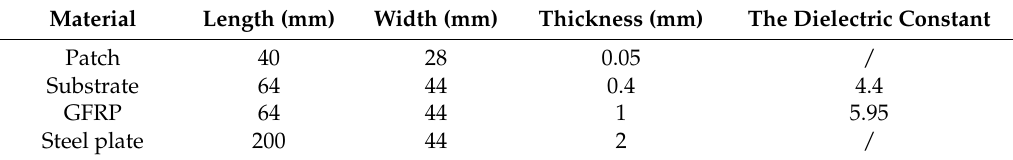
Figure 2. Multi-sectional view of the dual-substrate antenna sensor. Table 1. Geometrical dimensions and material properties of dual-substrate antenna sensor layers.